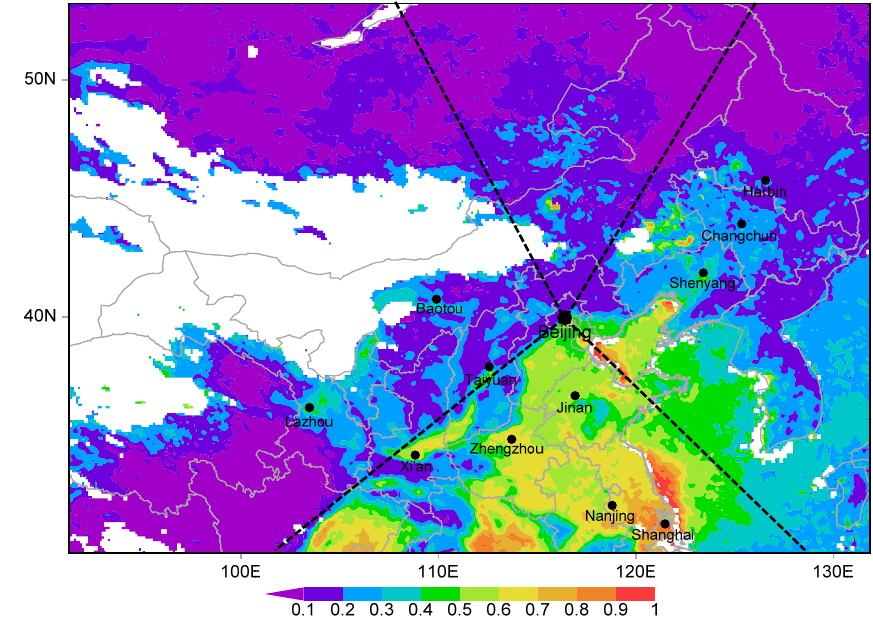
Fig. 1. Sampling location (116.30 ◦ E, 39.99 ◦ N) on a regional map superimposed with spatial distribution of annual mean fine aerosol optical depth (AOD) retrieved from MODIS satellite remote sensing in 2009. Dashed lines define four regions based on the trajectory clustering results discussed in Sect. 4.2 (seen in the text). Also shown are several major cities around